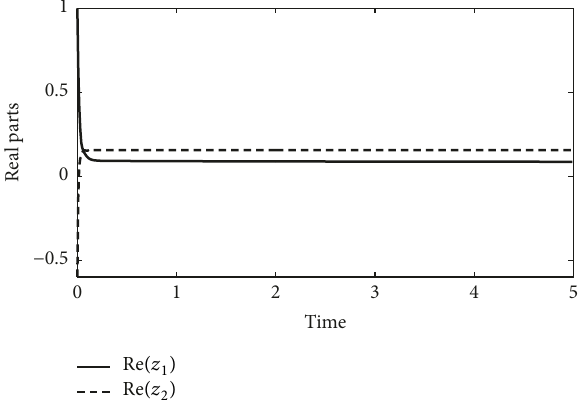
Figure 1: State curves of Re (𝑧 1 ) and Re (𝑧 2 ) without impulsive dis-